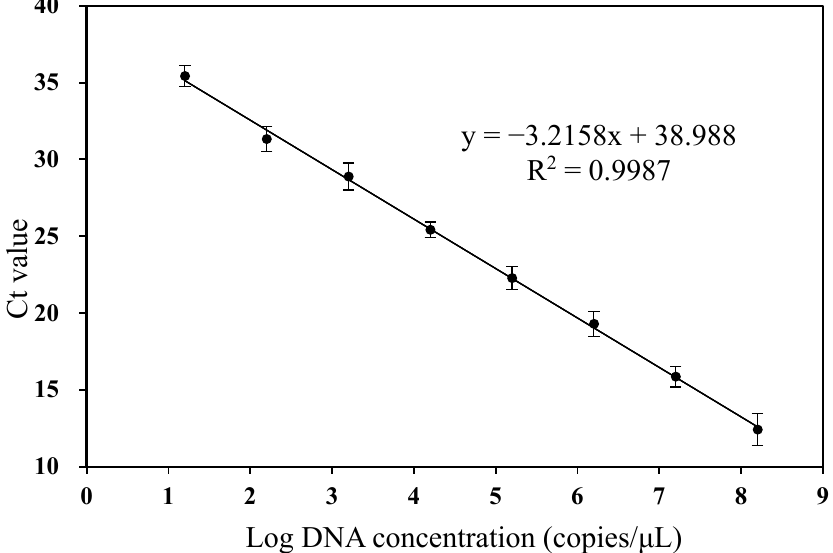
Figure 2. Standard curve of quantitative real-time reverse-transcription PCR (RT ‒ qPCR) generated using a 10-fold serial dilution of CGMMV plasmid ranging from 1.57 × 10 8 to 1.57 × 10 copies· μ L − 1 . Log values of the copy number were plotted against the corresponding threshold cycle (Ct) values obtained by RT ‒ qPCR, and the linear regression equation and correlation coefficient (R 2 ) are displayed in the graph. Error bars represent the standard deviation from three replicate reactions.